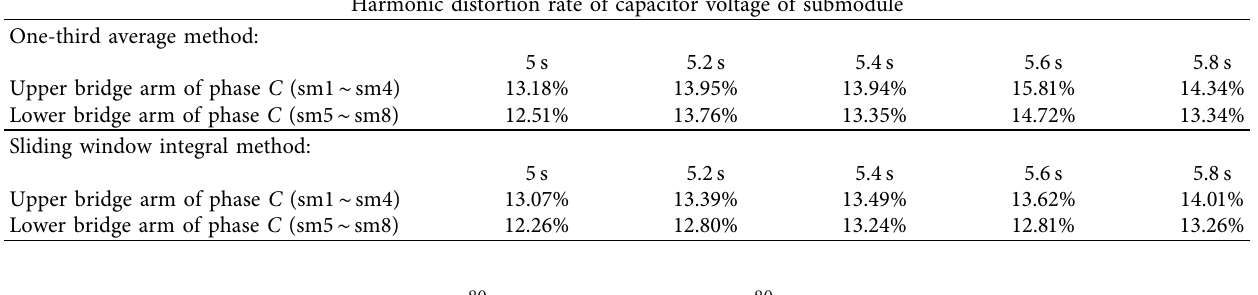
Table 4: Capacitor voltage distortion rate of c -phase submodule using one-third average method and sliding window integral method. Harmonic distortion rate of capacitor voltage of